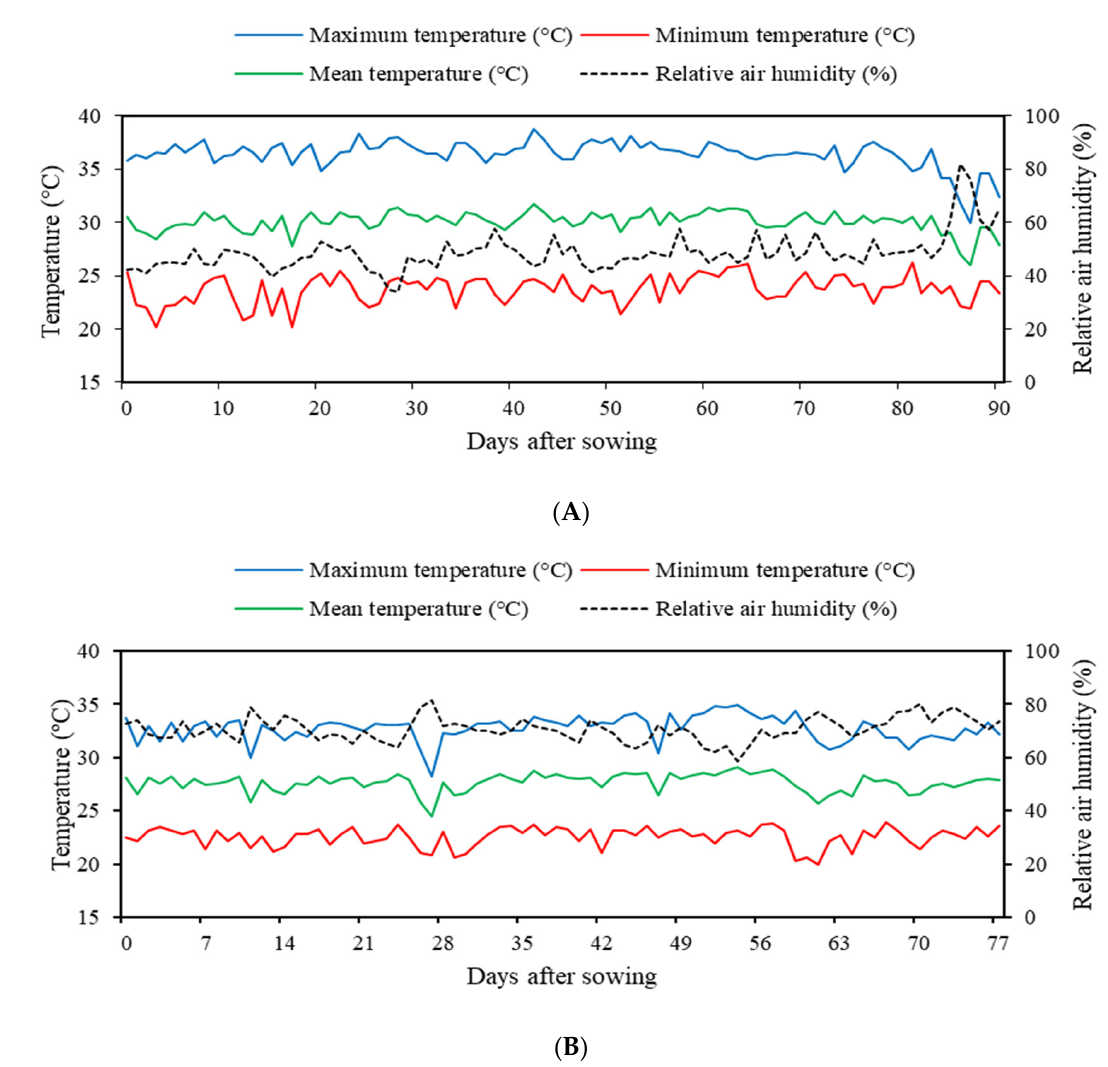
Figure 1. Maximum, minimum, and mean temperature and mean relative air humidity observed in the internal area of the greenhouse during the first ( A ) and second ( B ) experiment.